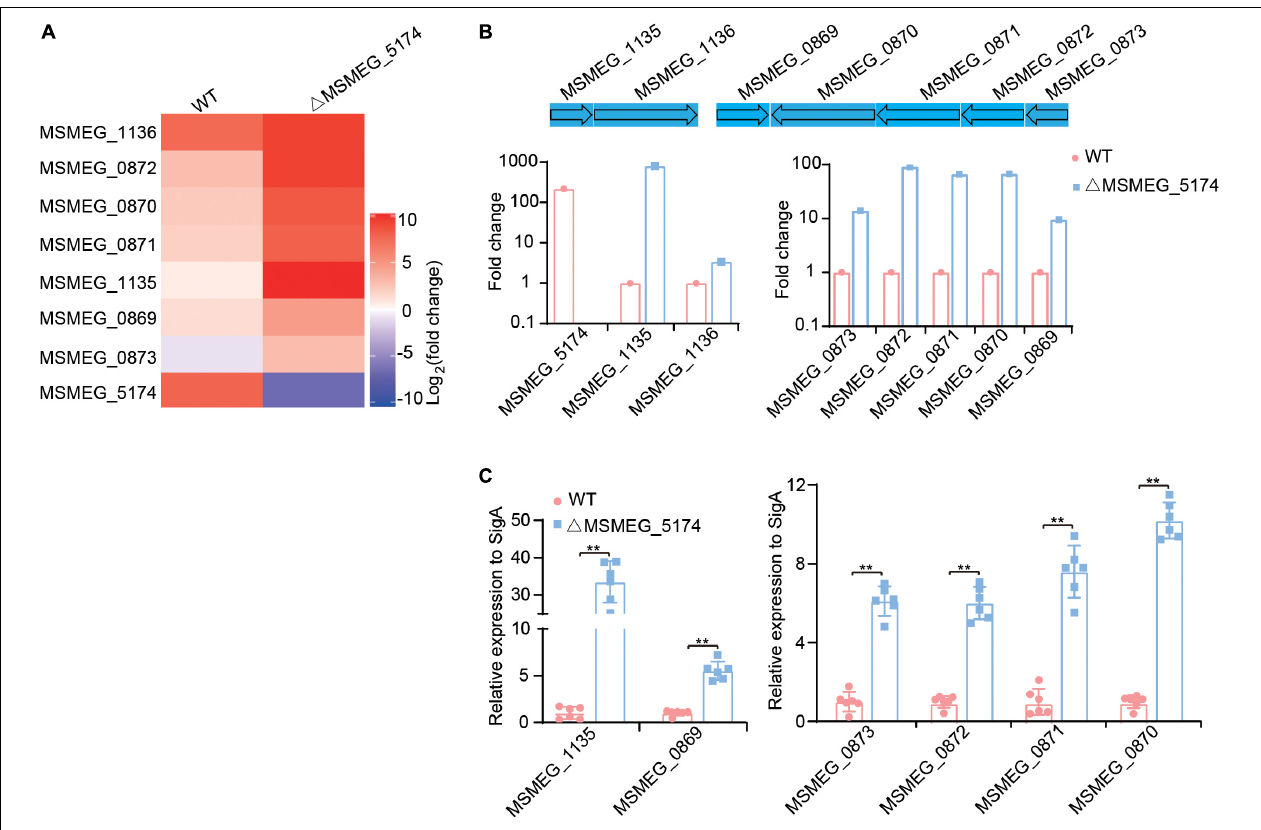
FIGURE 2 | Transcriptome profiling of WT and MSMEG_5174 mutants. (A) Heat maps of dysregulated genes in WT and MSMEG_5174 mutants. (B) The fold changes of gene expression in MSMEG_5174 mutants calculated and normalized to WT strains. (C) qRT-PCR was used to verify the expression of the genes in WT and MSMEG_5174 mutants. ** P <